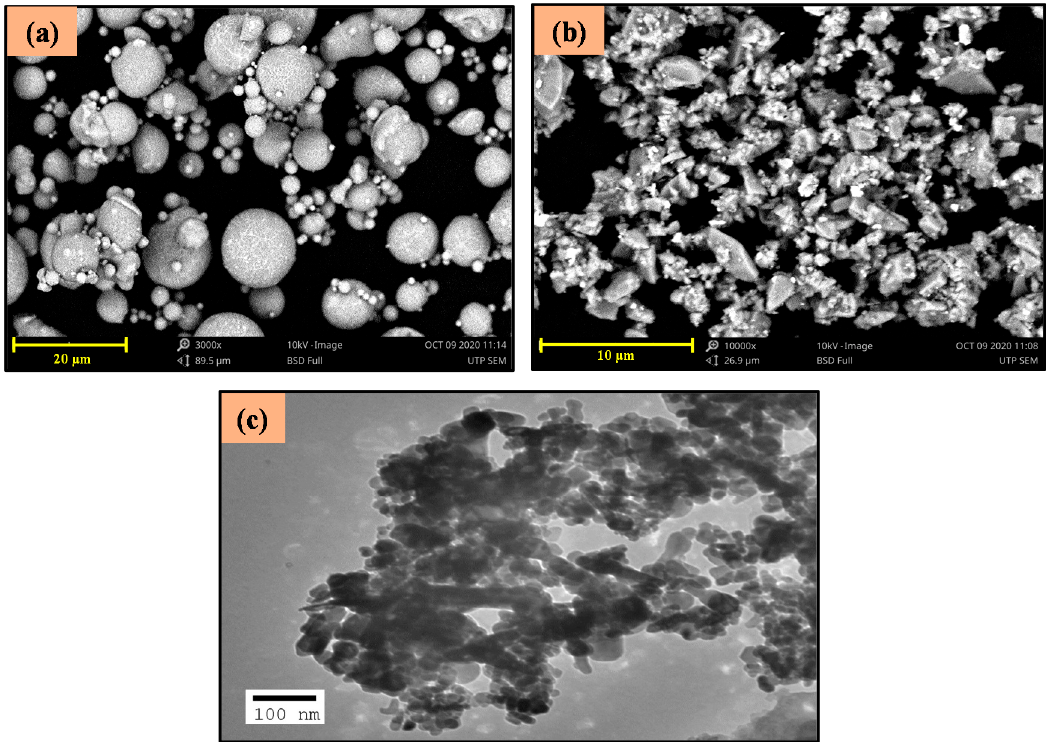
Figure 4. SEM micrographs of the received powder particles depicting ( a ) matrix AL7075, ( b ) rein- forcement TiC, and ( c ) TEM image of TiC particles. forcement TiC, and ( c ) TEM image of TiC